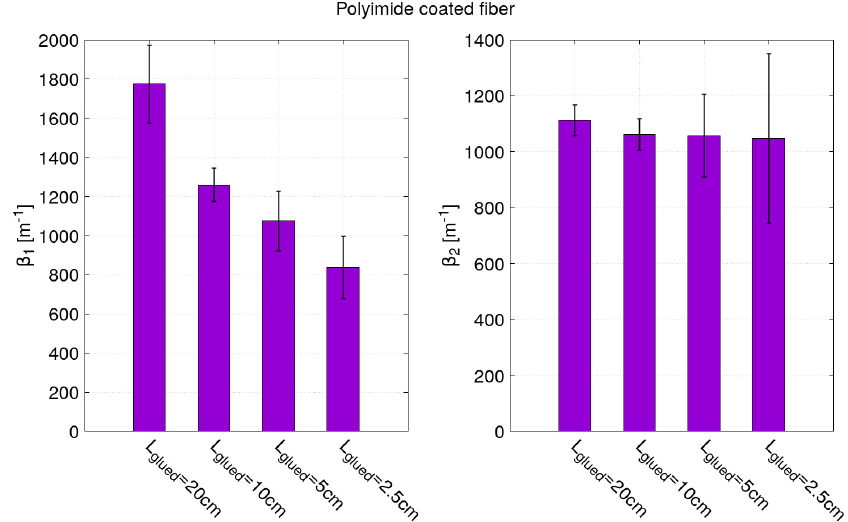
Figure 11. Fitting parameters β 1 and β 2 of the strain profiles obtained by optical fibers with poly- imide